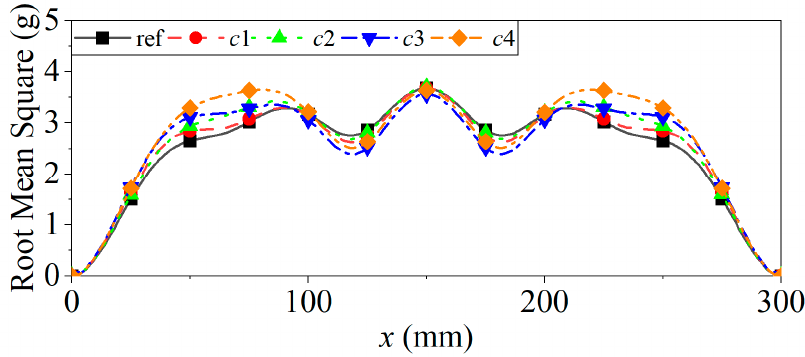
Figure 15. RMS of acceleration in the z-direction under di ff erent combined loads.